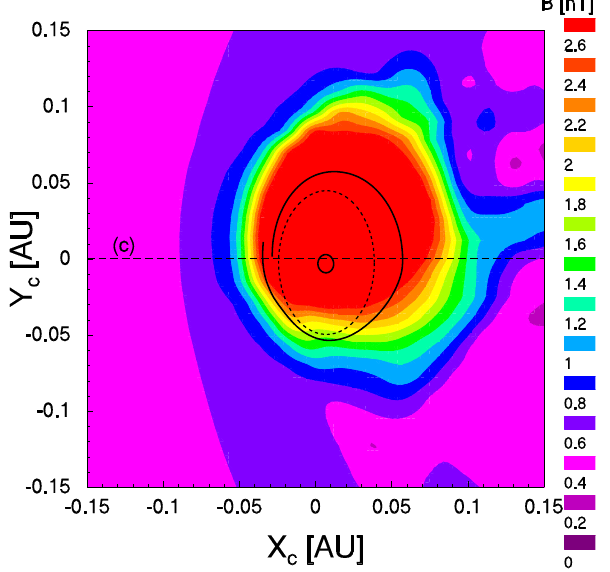
Fig. 4. Cross section through the flux rope around the point B. Outline is similar to Fig. 3.